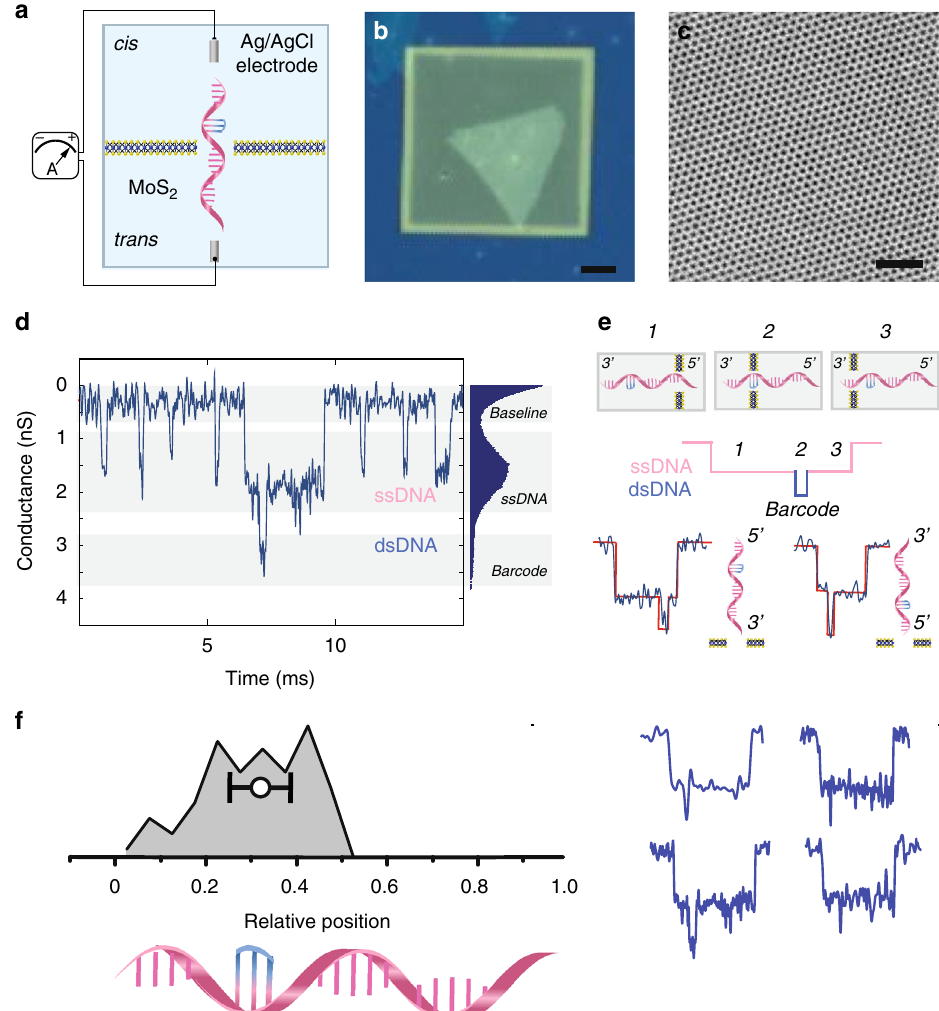
Fig. 4 a A schematic illustration of a MoS 2 nanopore membrane, where a barcoded DNA passes through a MoS 2 nanopore supported on the SiN x membrane. The device is mounted between two reservoirs fi lled with saline solution connected to a current ampli fi er to apply a transmembrane bias across the membrane. b A bright- fi eld optical image of as-transferred single-layer MoS 2 over the supporting SiN x membrane. Scale bar is 10 μ m. c An HRTEM image (high-resolution transmission electron microscopy) of the pristine MoS 2 lattice of size 12 nm × 12 nm. Scale bar is 2 nm. d A typical current trace illustrates one barcoded DNA signal together with other seven template ssDNA signals. The all-points histogram shows three discrete levels for an open pore baseline, ssDNA, and barcode, respectively. e A cartoon illustration of the translocation trajectory through the nanopore. The hypothesised current signal in nanopore shows the discrete 3-step process. In the experiments, two scenarios can be detected, one in which we have 3 ′ entering and another